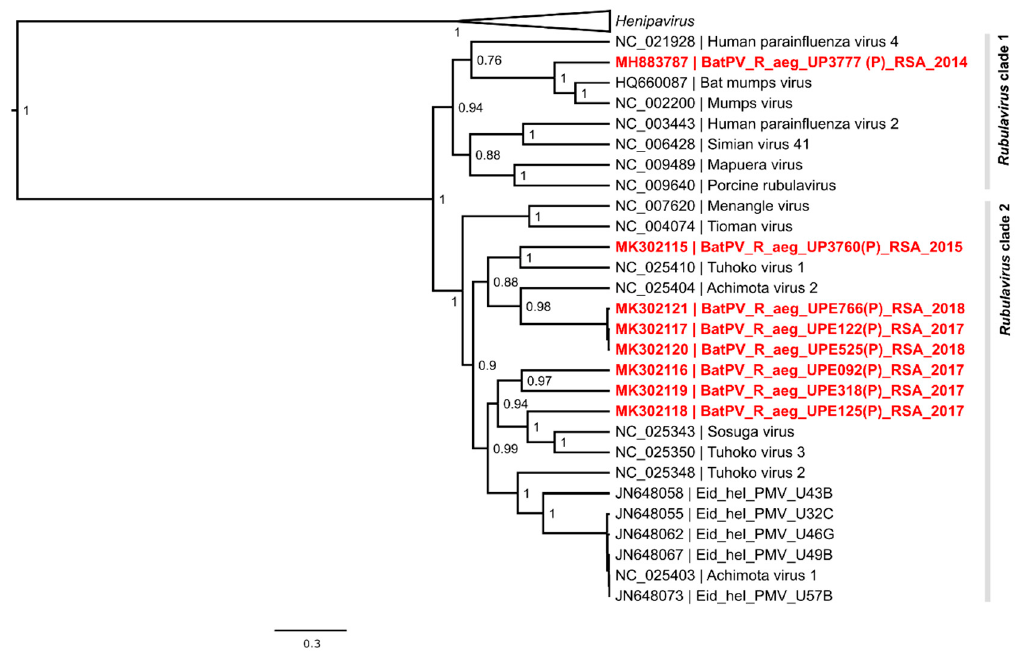
Figure A2. Bayesian phylogenetic analysis of a partial polymerase ( L ) gene region (529 nucleotide) of selected putative rubulaviruses detected in Rousettus aegyptiacus . Phylogenetic analysis was performed using the Hasegawa-Kishino-Yano model incorporating a gamma distribution (HKY + G). Sequence annotations include GenBank accession numbers.